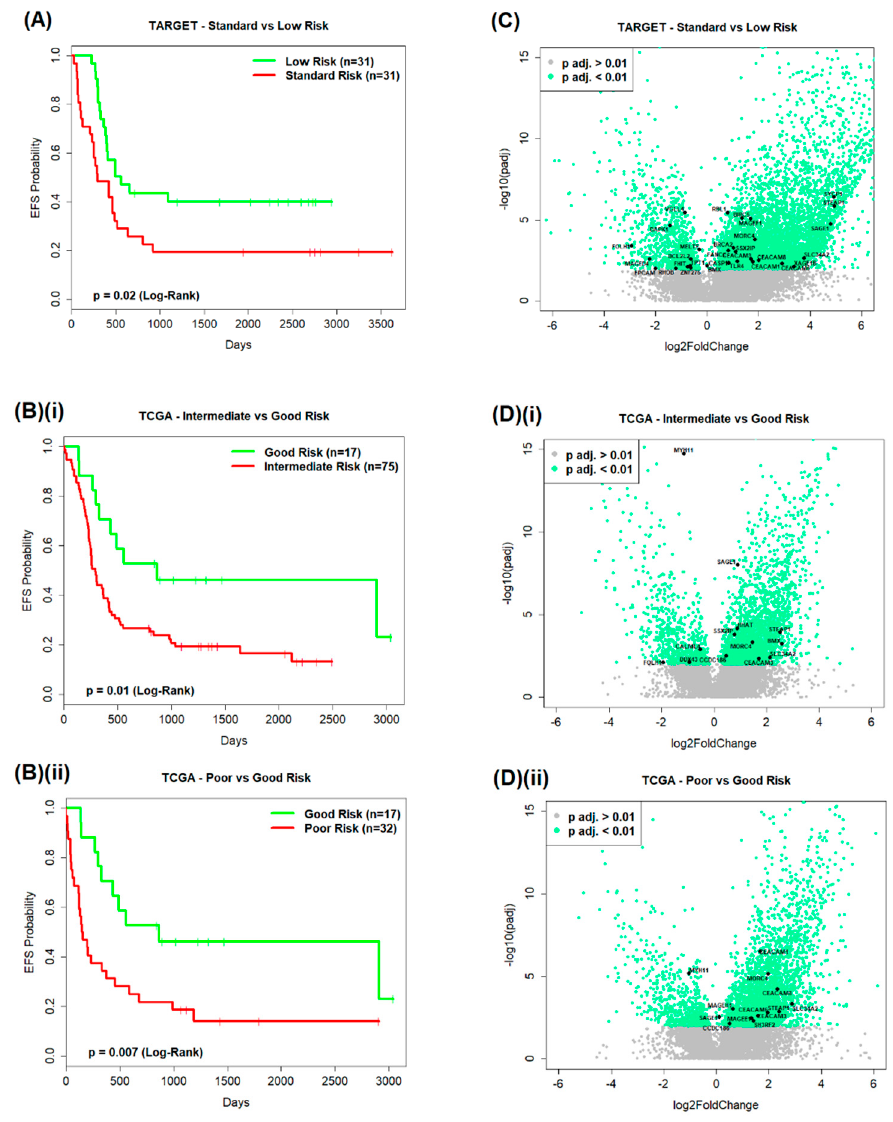
Figure 2. DGE analysis. Pairwise comparisons of event-free survival (EFS) of ( A ) TARGET patients by standard versus low risk ( p = 0.02), and ( B ) TCGA patients by ( i ) intermediate versus good risk ( p = 0.01) and ( ii ) poor versus good risk ( p = 0.007) subgroups. All p values derived from log-rank analysis. Volcano plots represent the genes that were differentially expressed by p > 0.01 (grey dots) or p < 0.01 (green dots) when comparing ( C ) TARGET patients by standard versus low risk, and ( D ) TCGA patients by ( i ) intermediate versus good and ( ii ) poor versus good risk subgroups. Names and black dots indicate the position of antigens listed as GOI when studying gene expression.